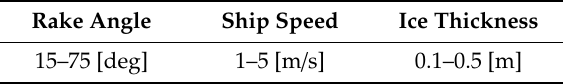
Table 8. Parameters investigated in parametric studies.